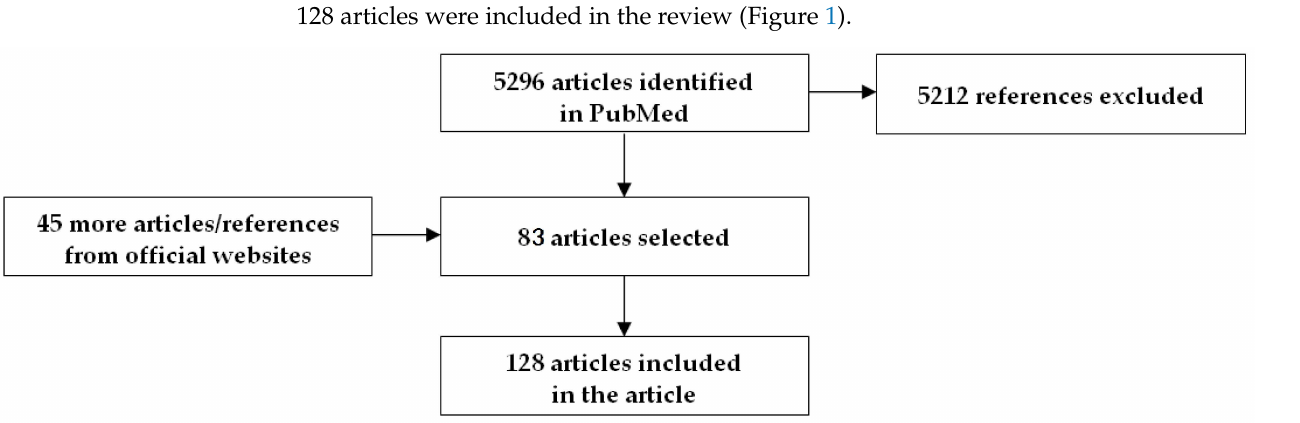
Figure 1. Flow diagram results of literature